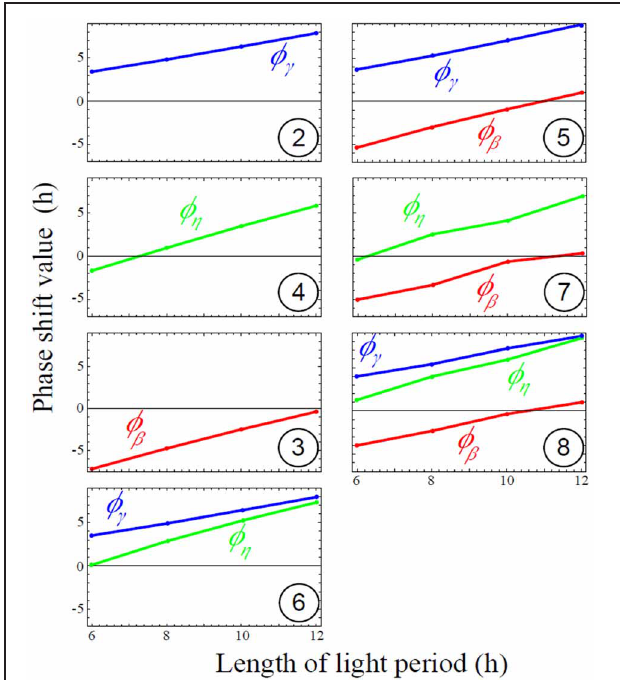
FIGURE 5 | Magnitude of rate phase shifts for each model depending on light period. Phase shift of all rates increases linearly (oscillations are delayed compared to the external L/D cycle) as the light period increases. Negative shift values mean oscillations are shifted left (in advance compared to the external L/D cycle), while positive shift values mean oscillations are shifted right (delayed compared to the external L/D cycle). Circled numbers stand for model number. Phase shift values of oscillating rates for the eight models depending on various L/D cycles conditions. Positive values mean right phase shift (or later internal peak) whereas negative values mean left phase shift (or earlier internal peak). No shift (zero) means that the internal circadian peak is synchronized with